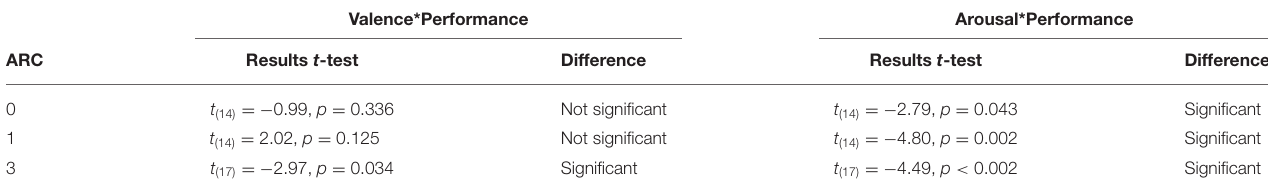
TABLE 4 | Results of one-sample t